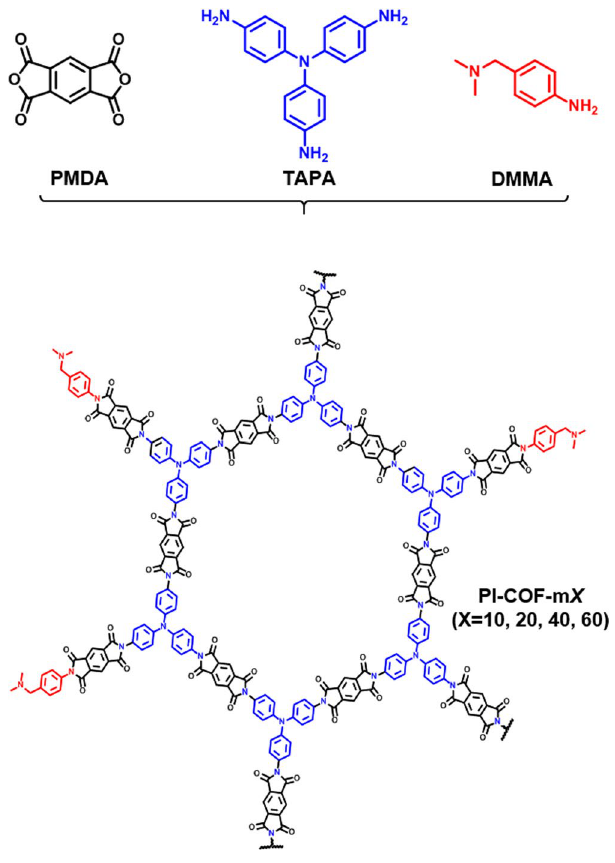
Figure 2. Synthesis scheme of PI-COF-m X . PI-COF-m X were synthesized via the co-condensation of PMDA (black) and TAPA (blue) with a modulator DMMA (red) serving as an SO 2 adsorption functional